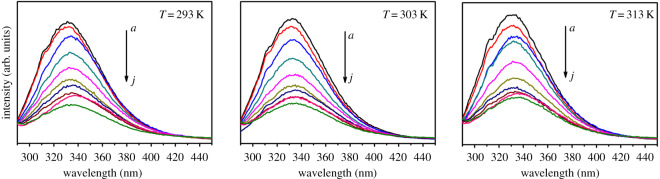
Fluorescence quenching spectra of BSA with various concentrations (a = 0.000, b = 1.85 × 10−5, c = 3.70 × 10−5, d = 5.55 × 10−5, e = 7.42 × 10−5, f = 9.25 × 10−5, g = 1.11 × 10−4, h = 1.29 × 10−4, i = 1.48 × 10−4, and j = 1.66 × 10−4 mol l−1) of SiO2@GdPO4:Tb@SiO2 nanoparticles at different temperature (λex = 280 nm). c(BSA) = 1.0 × 10−7 mol l−1.